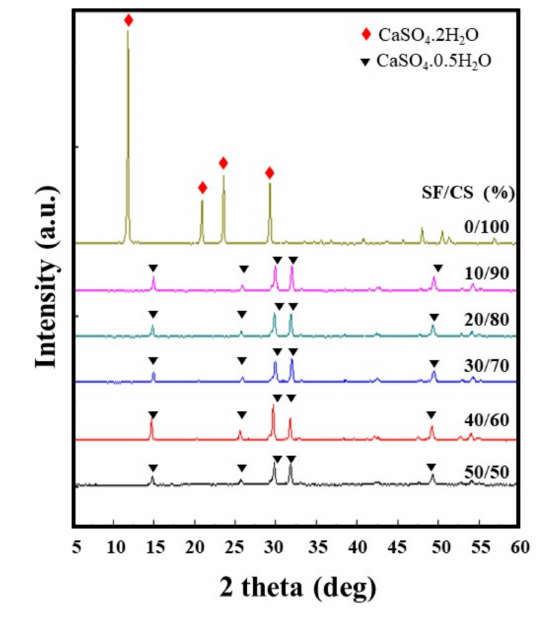
Figure 1. XRD pattern of various SF/CS